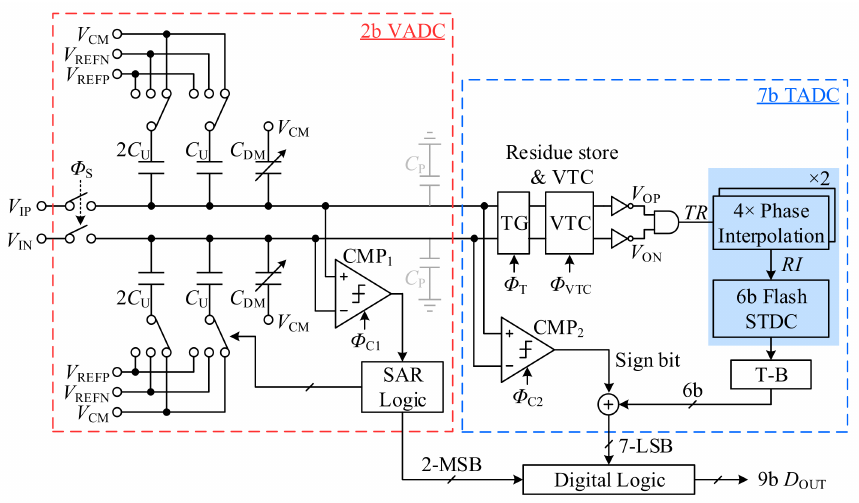
Figure 1. Architecture of the proposed two-stage